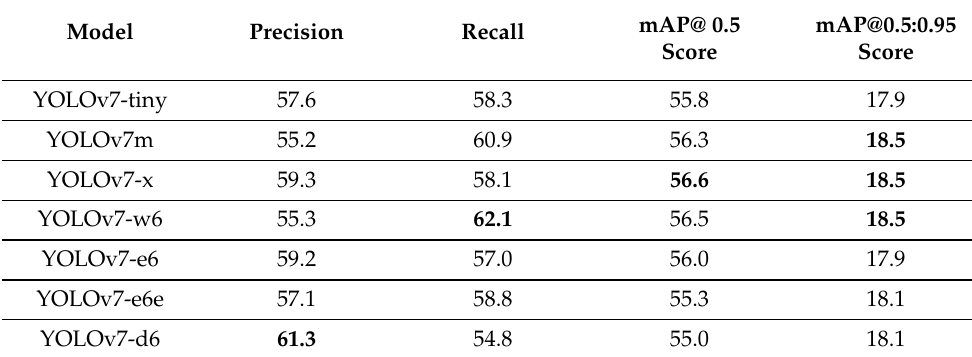
Table 6. Performance of all the YOLOv7 variants for the CP dataset. Best results are in bold.